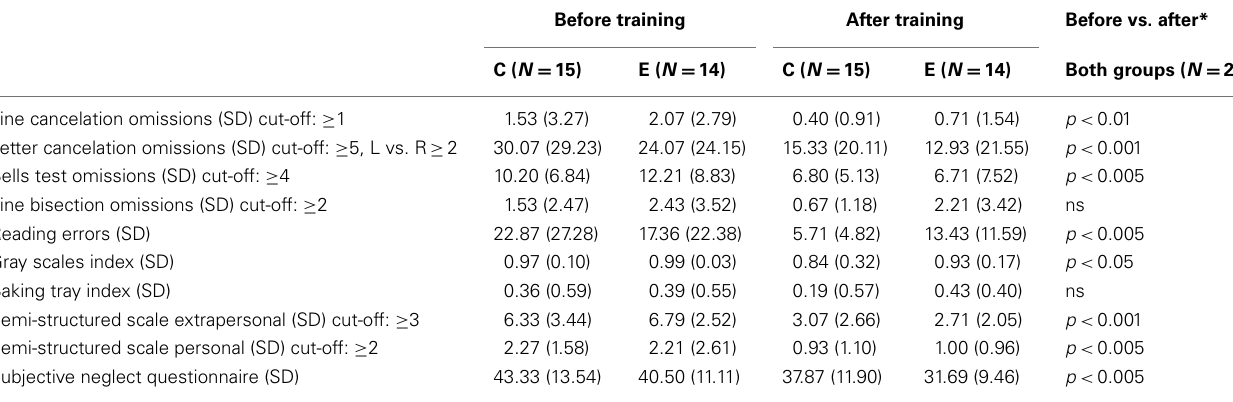
Table 3 | Mean scores and SDs on paper-and-pencil and driving measures before and after training for the control (C) and experimental (E) group. Before training After training Before vs. after*